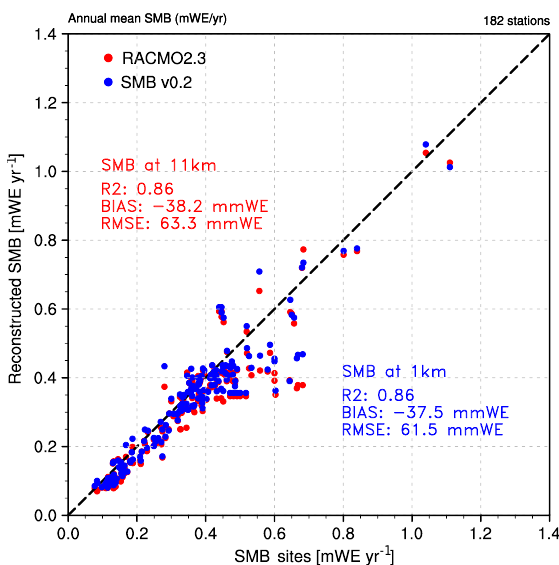
Figure 7. Comparison of accumulation observations collected at 182 sites with modelled SMB from RACMO2.3 at 11km (red) and downscaled SMB v0.2 at 1km (blue) in mWEyr − 1 . Note that bias correction has not yet been